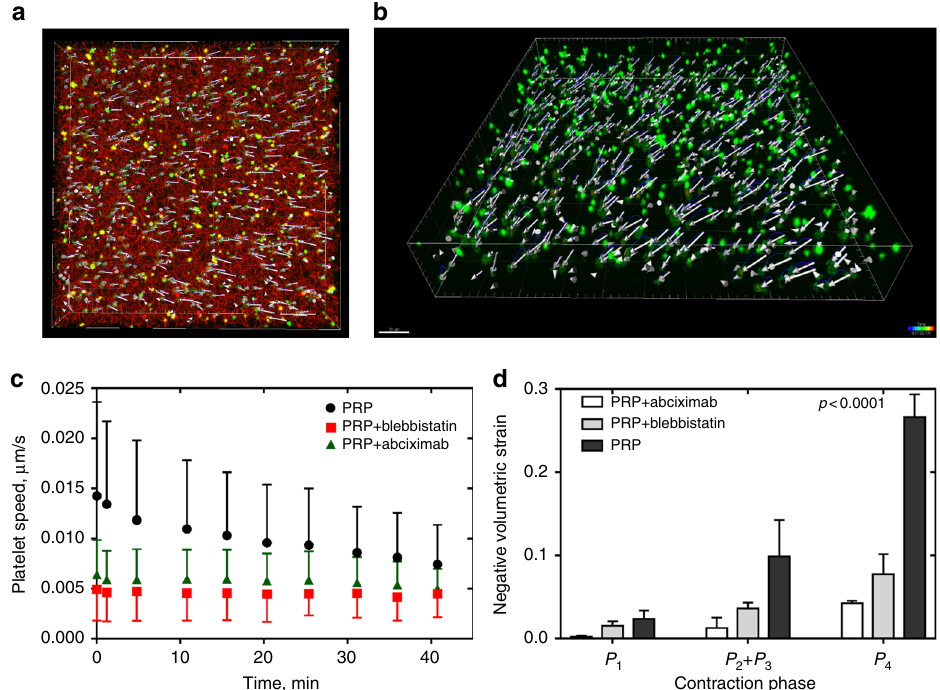
Fig. 5 Deformation of the platelet- fi brin meshwork during contraction quanti fi ed using platelet displacement as a marker indicative of local strain. a , b Representative images of a three-dimensional platelet displacement fi eld of a contracting clot; a top view , fi brin ( red ), platelet ( green ), and platelet displacement vectors are shown; b perspective view , platelets ( green ) with their displacement vectors are visualized. The clot volume analyzed was 217 µ m × 217 µ m × 34 µ m. c , d Changes of the platelet velocity during clot contraction c and clot volume reduction d in the absence and presence of blebbistatin (300 µ M) and abciximab (100 µ g/ml) (mean ± SD, 310 platelets analyzed in three clots). Statistical signi fi cance shown between the volumetric strains of contracted clots in the absence and presence of blebbistatin or abciximab; P < 0.05, Mann − Whitney U